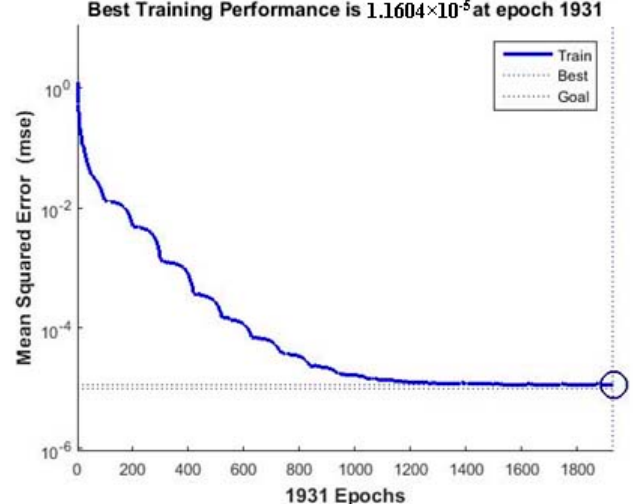
Figure 5. The performance of the BP-ANN model (4-4-1) in the training phase showing performance value (MSE-0.0000116) after 1931 epochs.